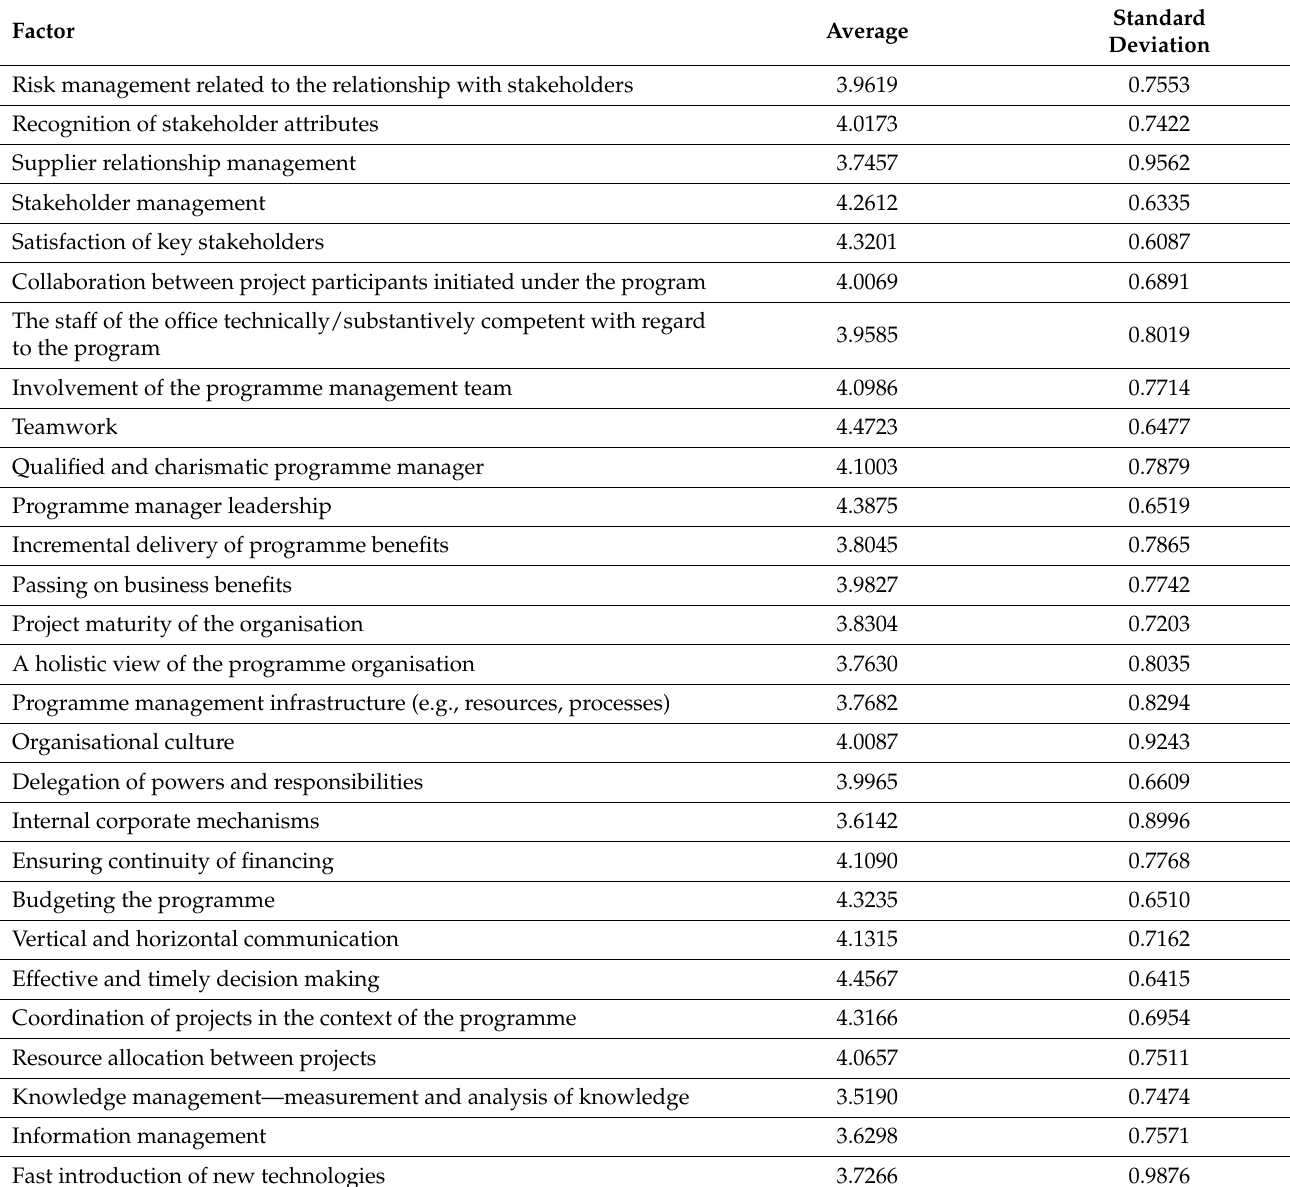
Table 2. Factors (variables) were adopted for the cluster